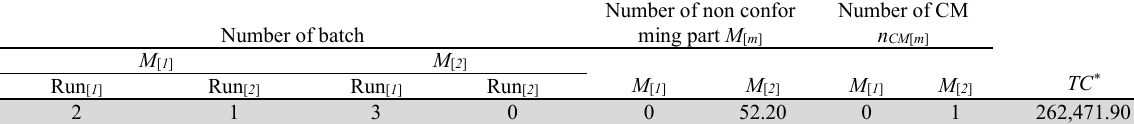
Number of CM Number of non confor n CM [ m ] ming part M [ m ]